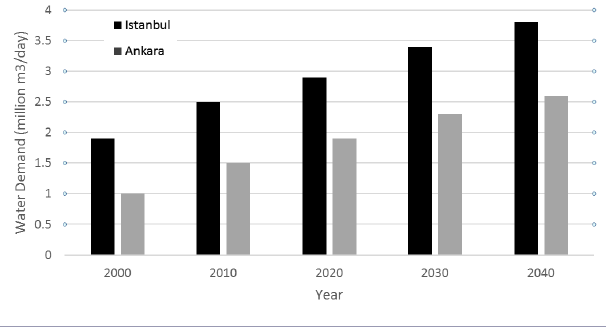
Fig. 1. Projected water demand for Istanbul and Ankara, Turkey.